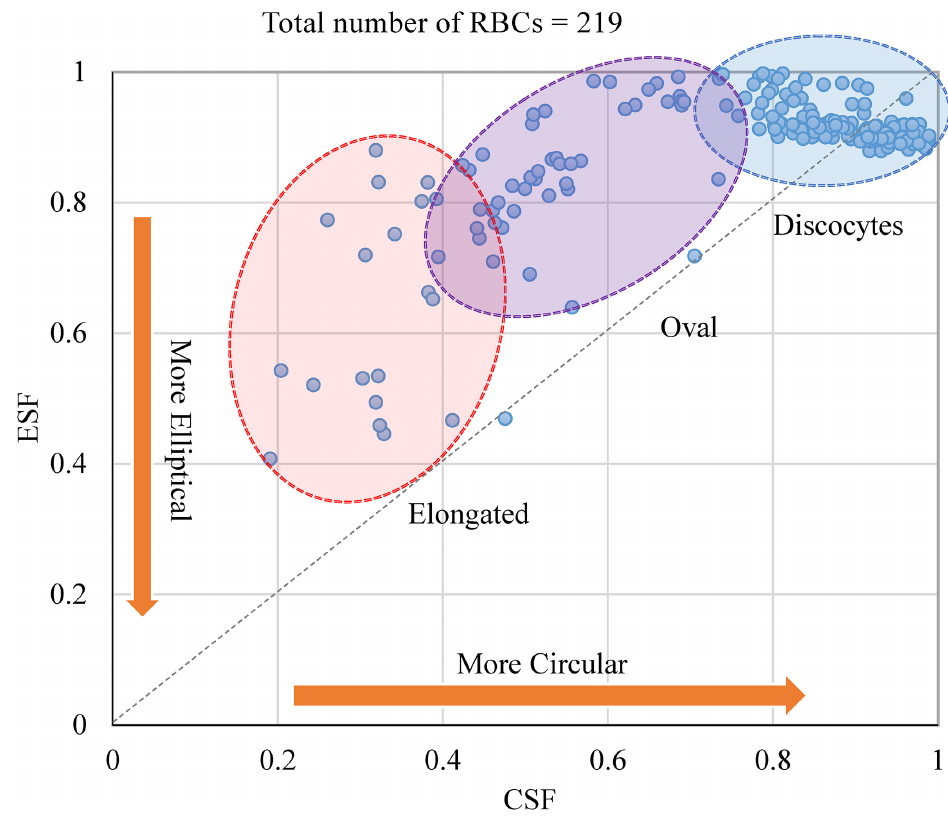
Fig 22. CSF and ESF shape factors estimation for Elongated, Oval and Discocytes RBC